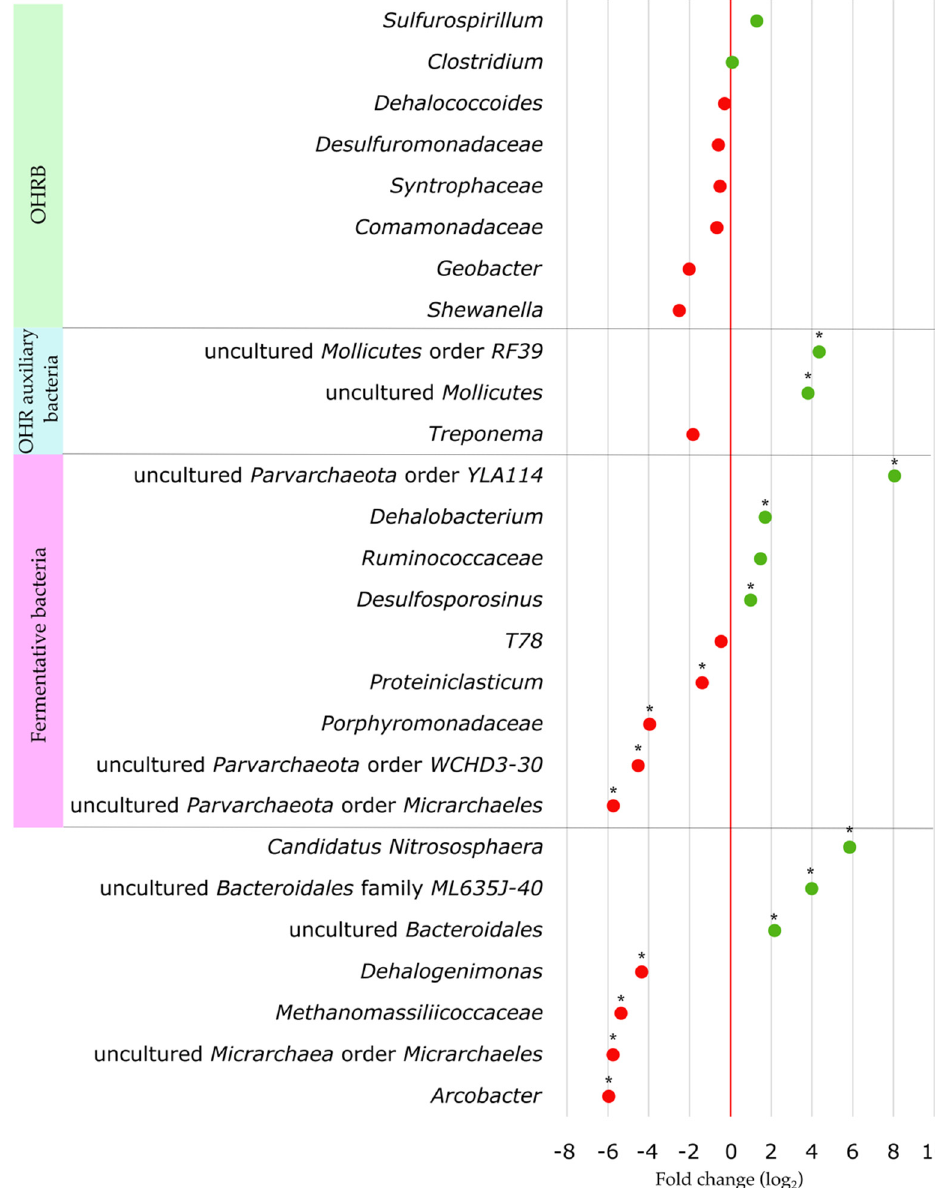
Figure 8. Differential abundance analysis performed on bacterial and archaeal taxa at genus level ( p ≤ 0.05) over 20 months of treatments. Relative abundance of OHRB, bacteria that have an auxiliary role in OHR activity and the fermentative bacteria involved in reducing power production. * indicates significant variation of relative abundance during the considered time frame ( p ≤ 0.05).